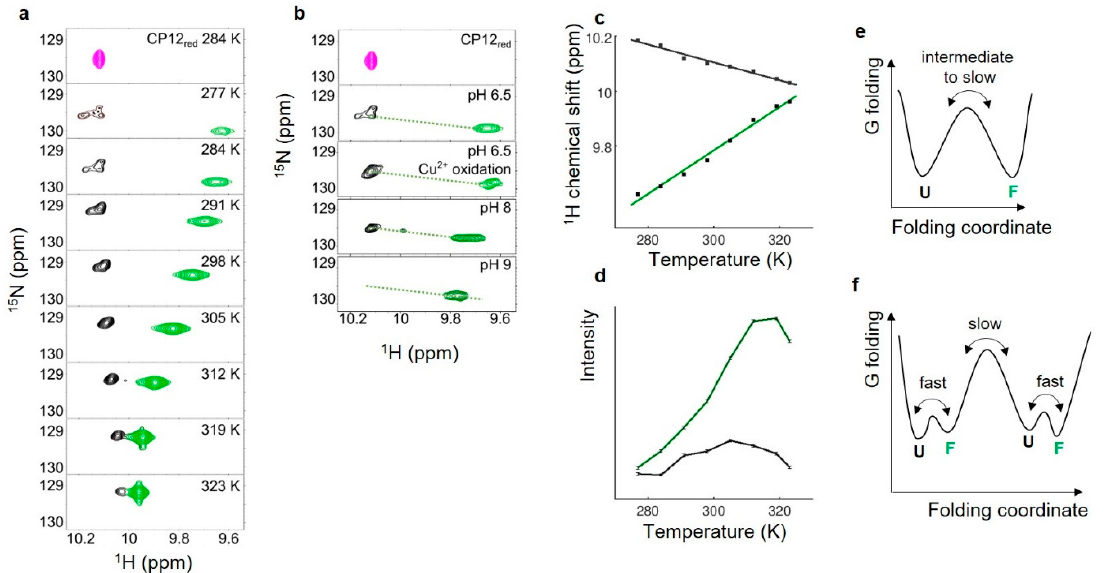
Figure 3. Temperature dependence of CP12 ox Trp- ε resonances indicating a chemical exchange. ( a ) Series of 1 H- 15 N spectra of CP12 ox recorded at varying temperatures (277 K, 284 K, 291 K, 298 K, 305 K, 313 K, 319 K) and at pH 6.5 and plotted with the same contour levels. To ease the reading, the contour levels of each resonance have different colors. In ( a , b ), above the series, the spectrum of CP12 red at 284 K is shown (magenta). ( b ) 1 H- 15 N spectra of CP12 recorded at 284 K at varying pH (pH 6.5 as in A, pH 8, and pH 9). An additional spectrum is shown at pH 6.5 where the protein has been pre-treated with Cu 2+ to ensure full oxidation. The paramagnetic ion was removed by dialysis before NMR acquisition. ( c ) Temperature dependence of the proton chemical shift for each of these CP12 ox Trp- ε resonances using the same color coding (Figure S4). ( d ) Temperature dependence of the resonance intensity for each of these CP12 ox Trp- ε resonances using the same color coding (refer to Figure S5). ( e , f ) Gibbs free energy of folding for the Trp- ε residue, with two possible interconversion models. The timescales of interconversion are indicated above the arrow.